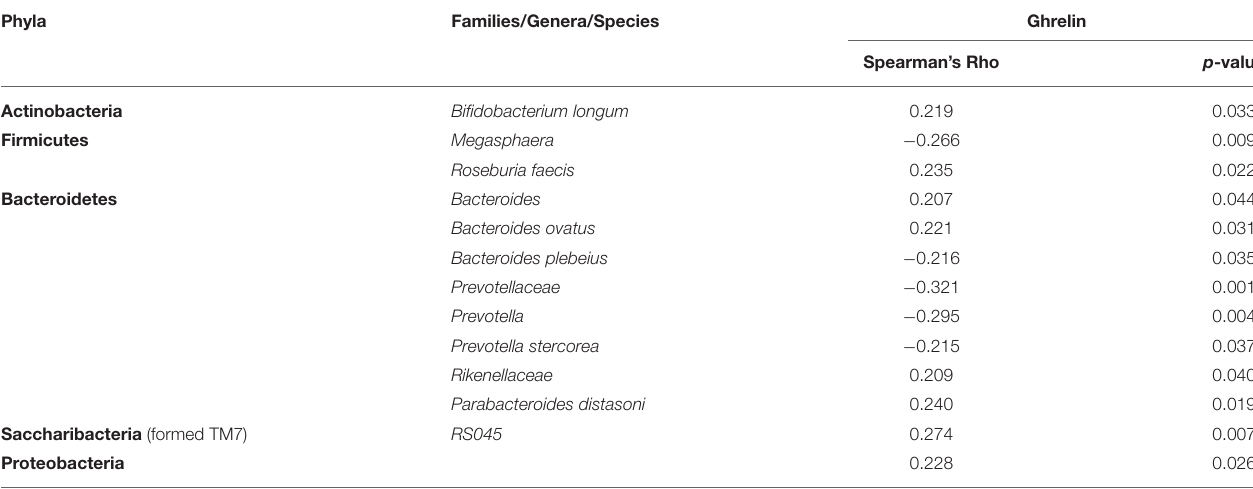
TABLE 1 | Linear correlation between bacteria and fasting ghrelin levels.